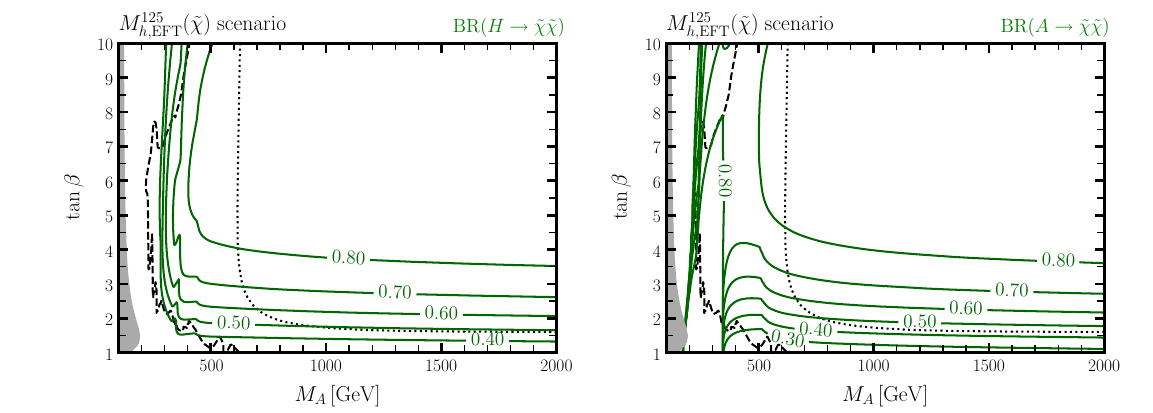
Fig. 7 Branching ratios of the decays of the heavy CP -even Higgs boson H ( left ) and the CP -odd Higgs boson A ( right ) into elec- troweakino pairs, shown in the ( M A , tan β ) plane in the M 125 scenario. The contributions from all kinematically allowed combina-